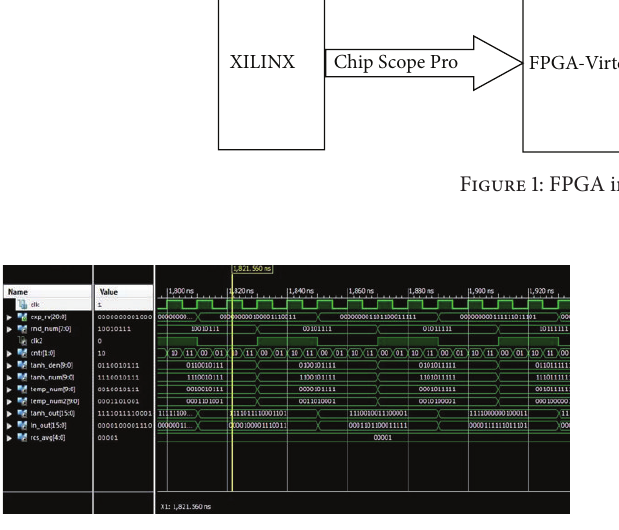
Figure 2: Simulations results for exponential distribution simula- tion on Virtex-6 FPGA. Figure 3: Simulations results for FPGA 4th degree Chi-square distribution simulation on Virtex-6 FPGA.